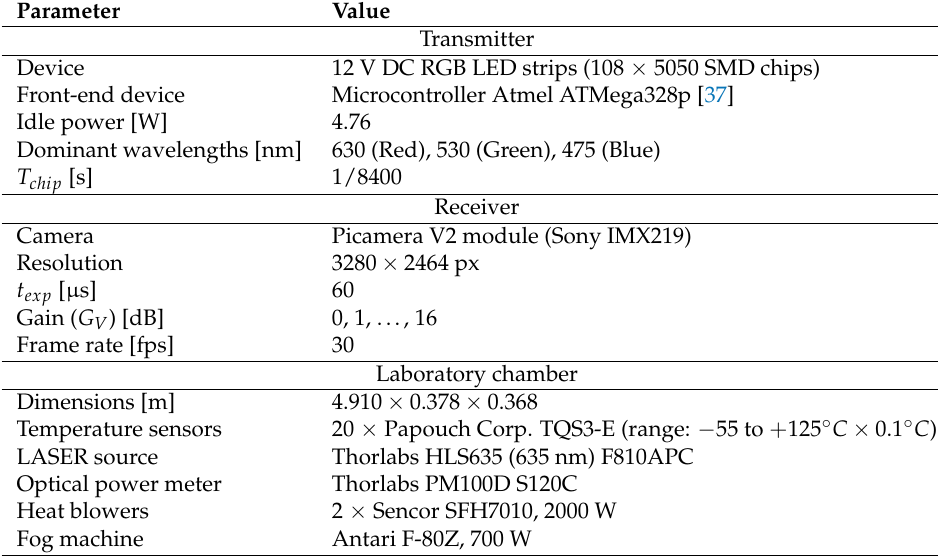
Figure 4. Block diagram of the experimental setup. Table 2. Experiment key